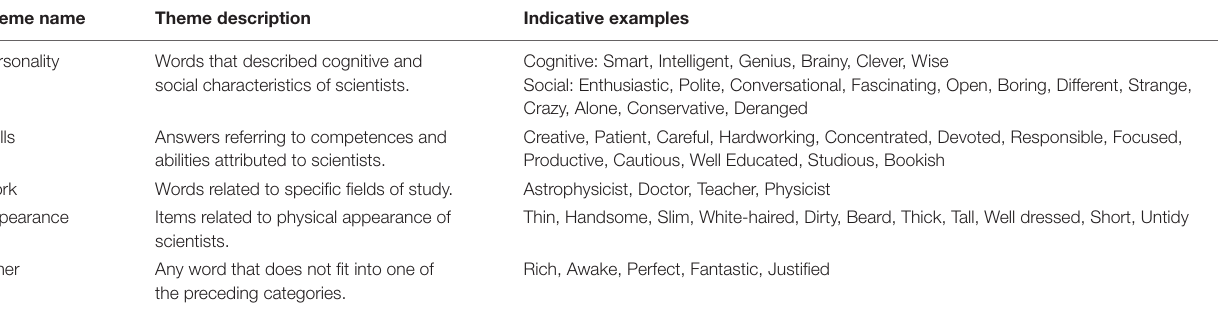
TABLE 4 | Framework for analysis of children’s responses to “What three adjectives would you use to describe a